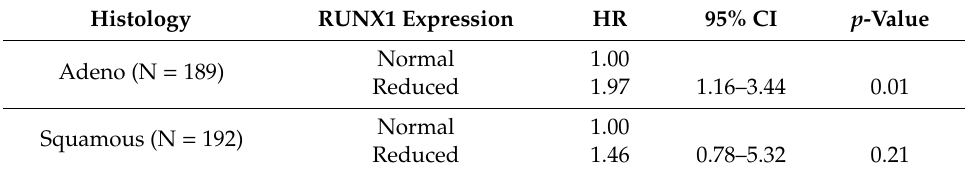
Table 1. Cox proportional hazards analysis of overall survival according to RUNX1